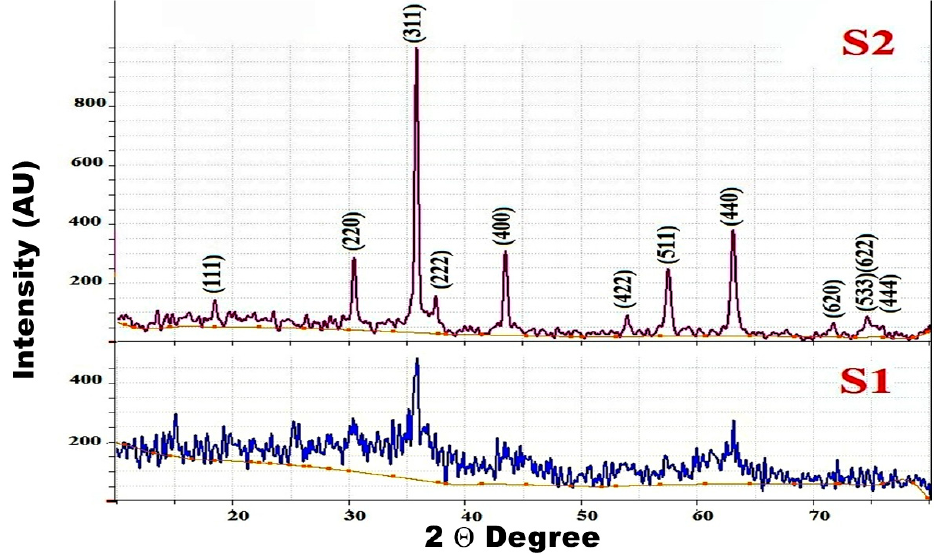
Figure 1. XRD patterns of S1 and S2 samples.